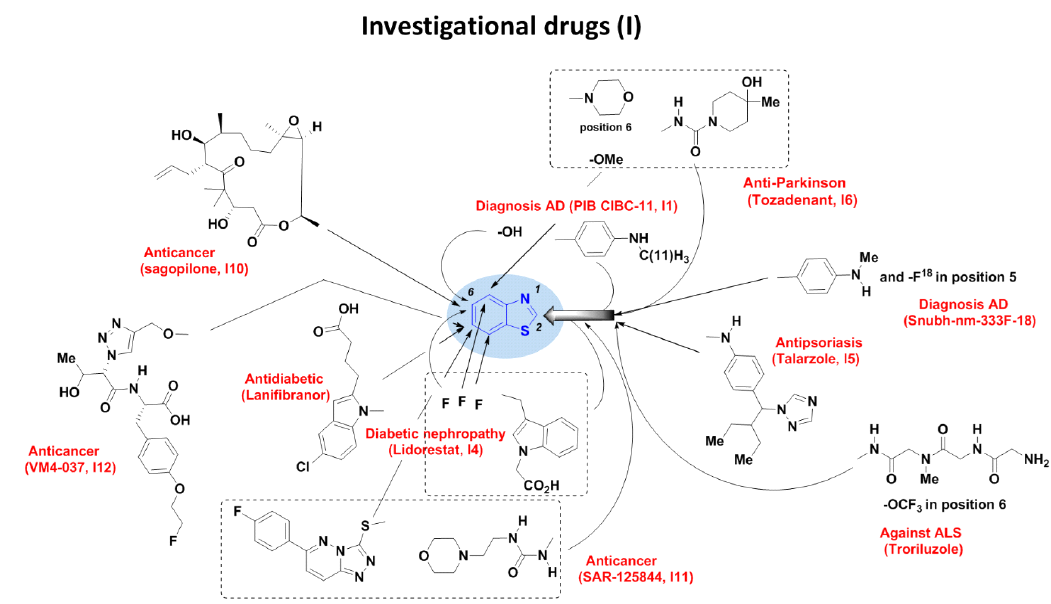
Figure 5. Figure 5. Substituents displayed by the investigational 1,3-benzothiazole drugs included in DrugBank [3].